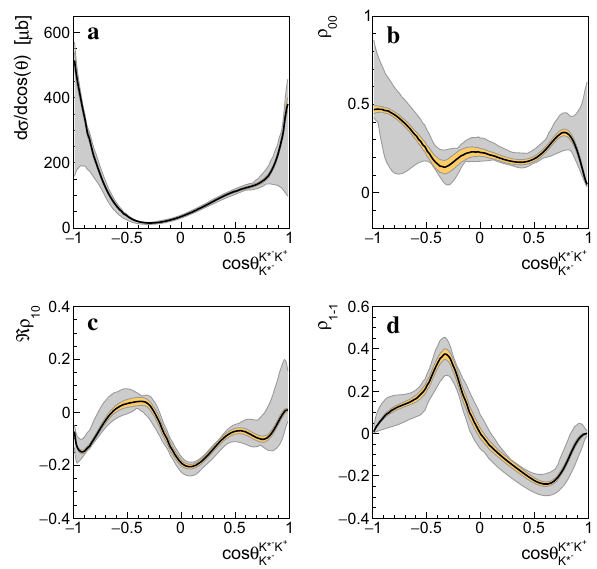
Fig. 18 Differential production cross section ( a ) and spin density matrix elements ρ 00 ( b ), (cid:13) ρ 10 ( c ) and ρ 1 − 1 ( d ) of the K ∗ ( 892 ) − in ¯ pp → K ∗ ( 892 ) K . All elements are shown in the helicity system of the K ∗− . The yellow and the gray bands stand for the statistical and systematic uncertainty,